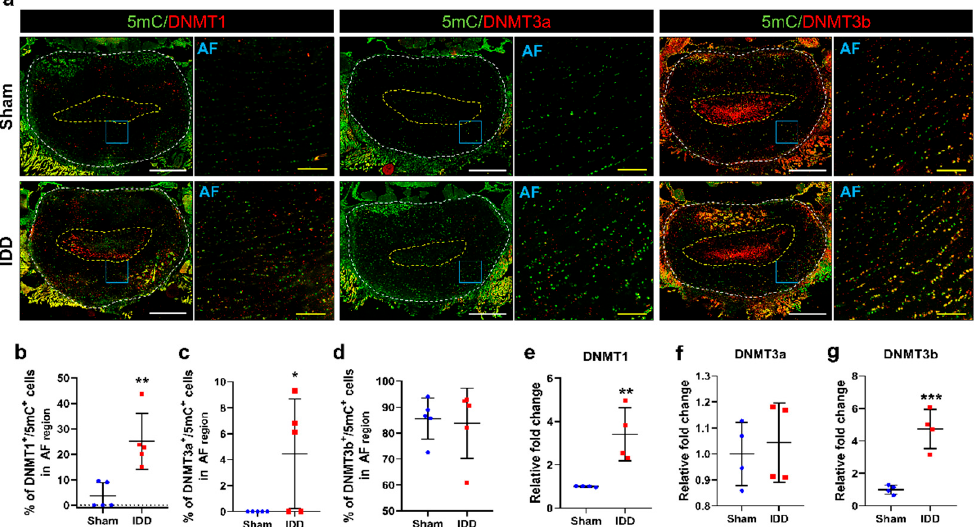
Figure 5. ( a ) Representative immunohistochemical low and high images for 5mC (green) and DNMT1, DNMT3a, or DNMT3b (red) in the AF regions of the sham and IDD groups. White scale bar = 1000 µm, Yellow scale bar = 100 µm; ( b – d ) The percentage of cells double-stained with DNMT1, DNMT3a, or DNMT3b (red) and 5mC (green) in the AF regions of the sham and IDD groups ( n = 5/group); ( e – g ) Relative fold change of DNMT1 , DNMT3a , or DNMT3b mRNA levels in the sham and IDD groups ( n = 4/group). Data are expressed as the mean ± SEM. Significant differences indicated as * p < 0.05, ** p < 0.01, and *** p < 0.001 vs. sham group were analyzed via unpaired t-tests with Welch’s correction. 5-methylcytosine; AF, annulus fibrosus; DNMT, DNA methyltransferase; IDD, intervertebral disc degeneration; SEM, standard error of the mean.